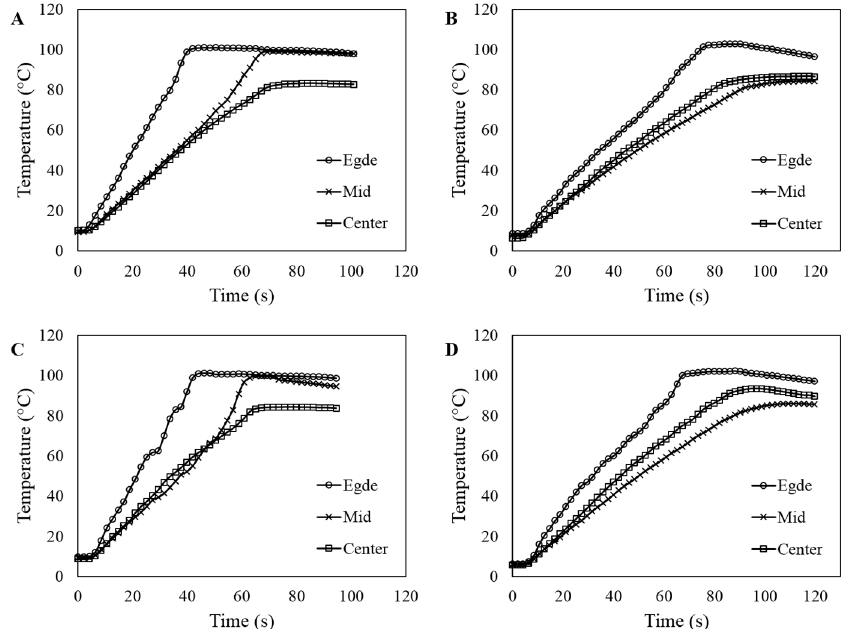
Figure 5. Time–temperature profile at the edge, mid-way, and the center position of the pork patties containing different salt and water levels in the container without lid during microwave heating.